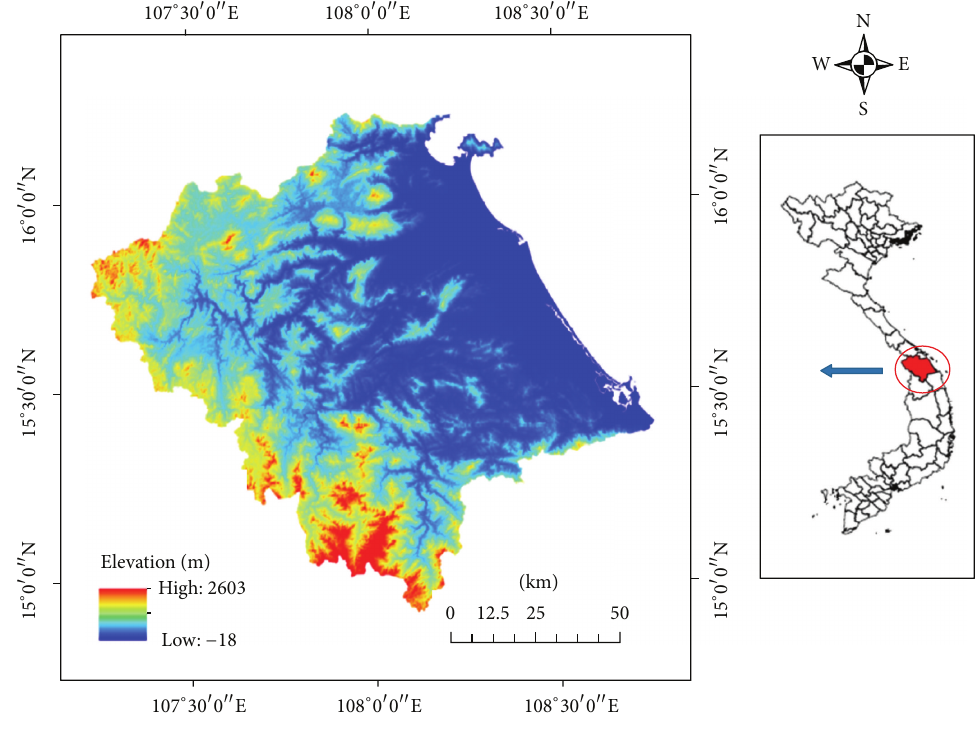
Figure 1: Vu Gia Thu Bon river basin in central Vietnam.